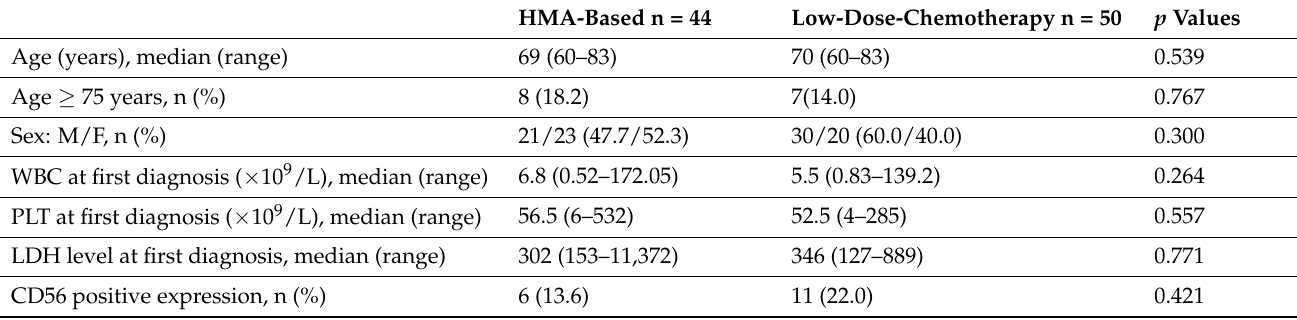
Table 1. Patient demographics and baseline